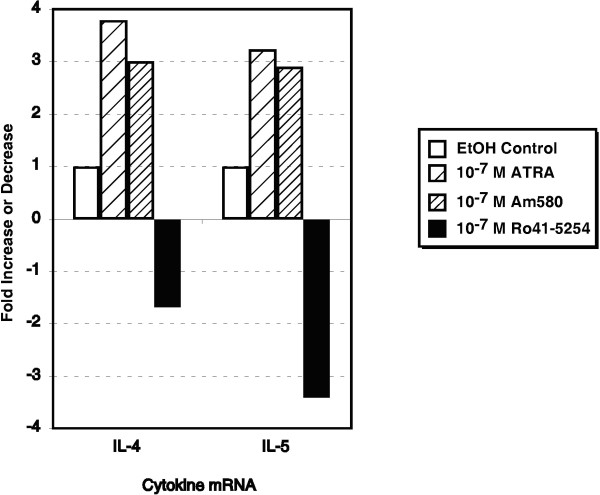
ATRA and an RAR- -α agonist upregulate and an RAR-α antagonist downregulates the expression of IL-4 and IL-5 mRNA in anti-CD3, -activated PBMC. Taqman® semi-quantitative PCR for IL-4 and IL-5 transcripts was performed using total cellular RNA of 48 h, anti-CD3,-activated PBMC treated with EtOH, ATRA (10-7 M), an RAR- α agonist, AM580 (10-7 M), or an RAR- α antagonist, RO 41–5254 (10-7 M). Values obtained for each cytokine message was normalized to that obtained for 18S rRNA in the same sample as described in "Materials and Methods". The normalized values were then expressed as a function of the ETOH control sample. The data are representative of all of the donors tested.